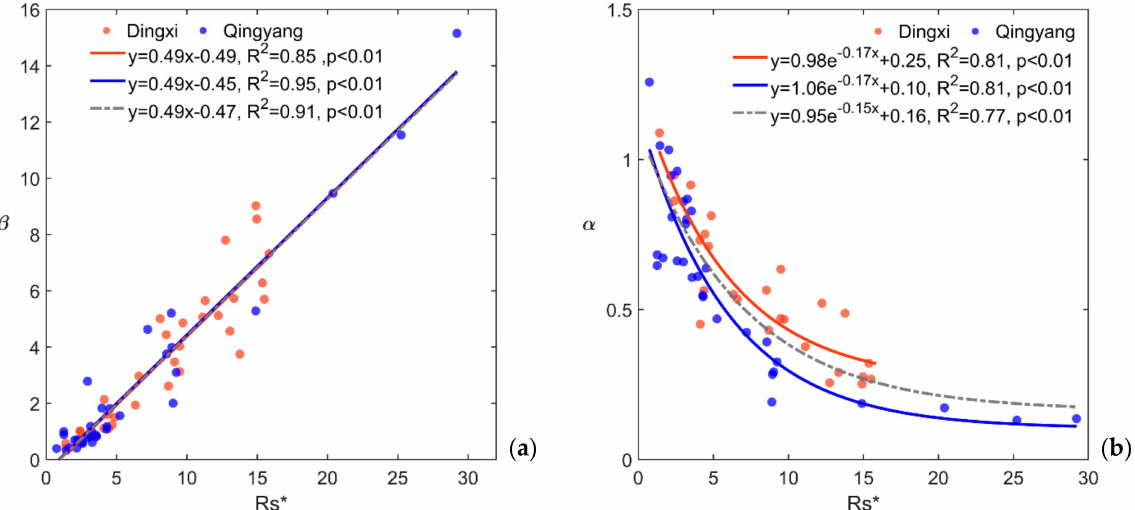
Figure 12. Relationships between the normalized surface impedance ( Rs ∗ ) and ( a ) β and ( b ) α on a monthly time scale. The gray dotted line in the figure represents the overall trend of the above